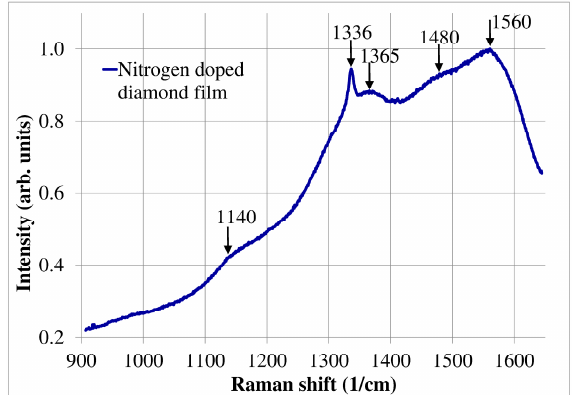
Figure 3. The Raman spectrum of the nitrogen-doped diamond film.